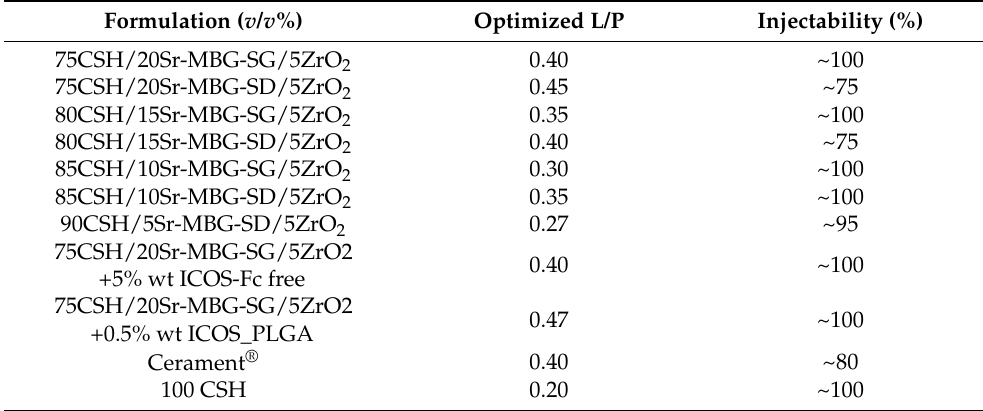
Table 2. Optimized L/P and corresponding injectability for the tested formulations of the injectable